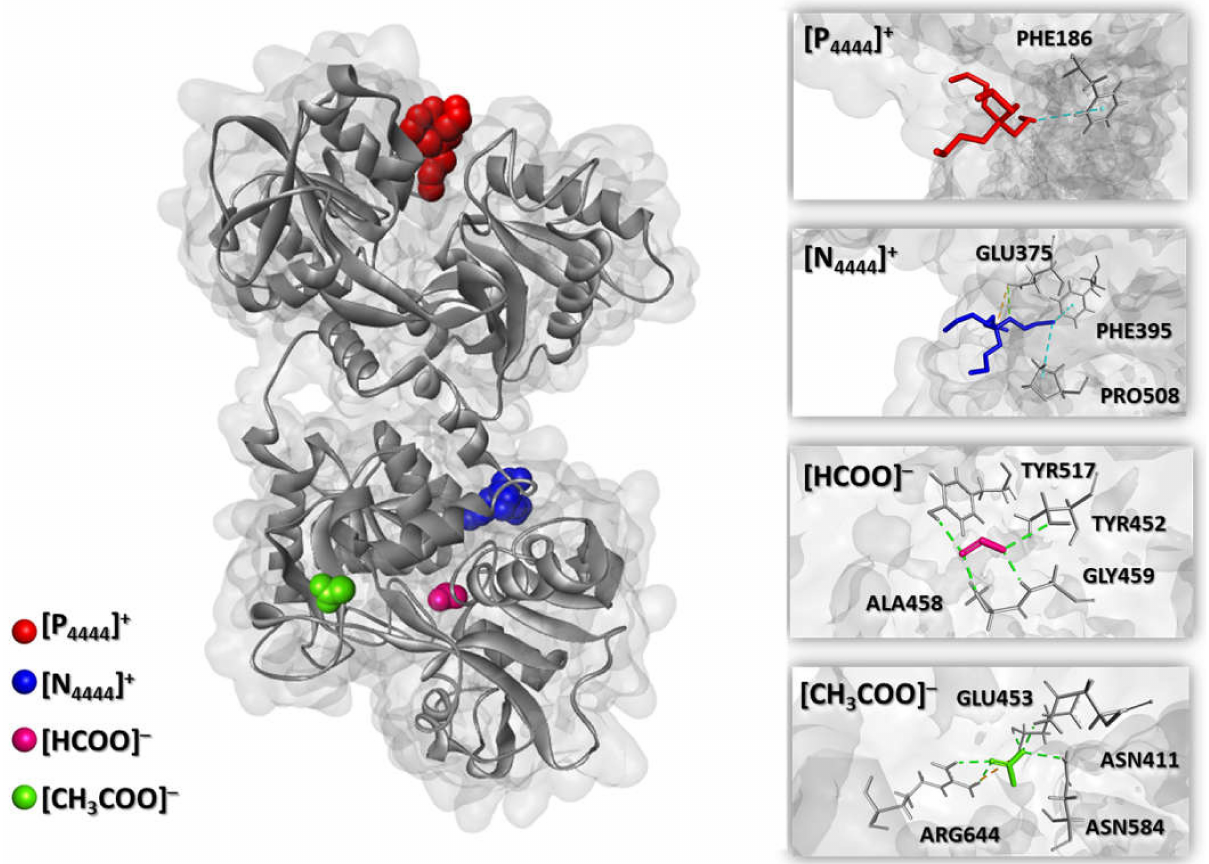
Figure 6. Docking pose with the lowest absolute value of affinity (kcal · mol − 1 ) and interacting amino acids for transferrin (pH